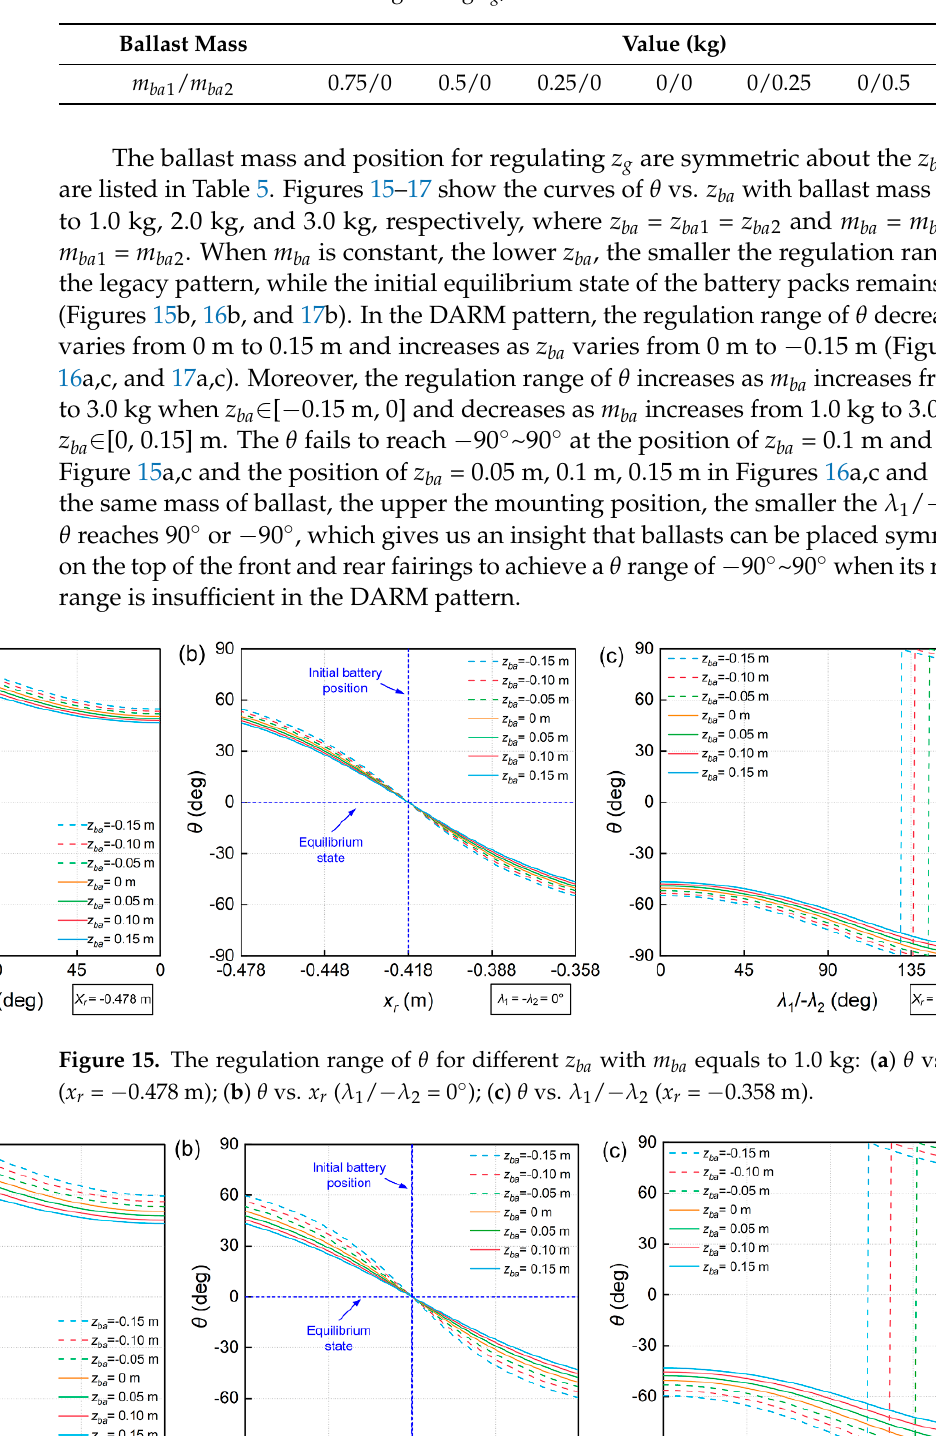
Table 4. The mass of ballast for regulating x g.